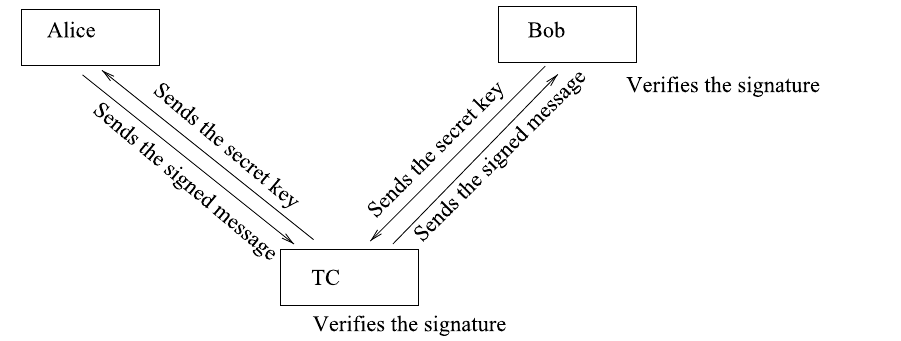
Fig 1. Quantum signature scheme based on amplitude amplification